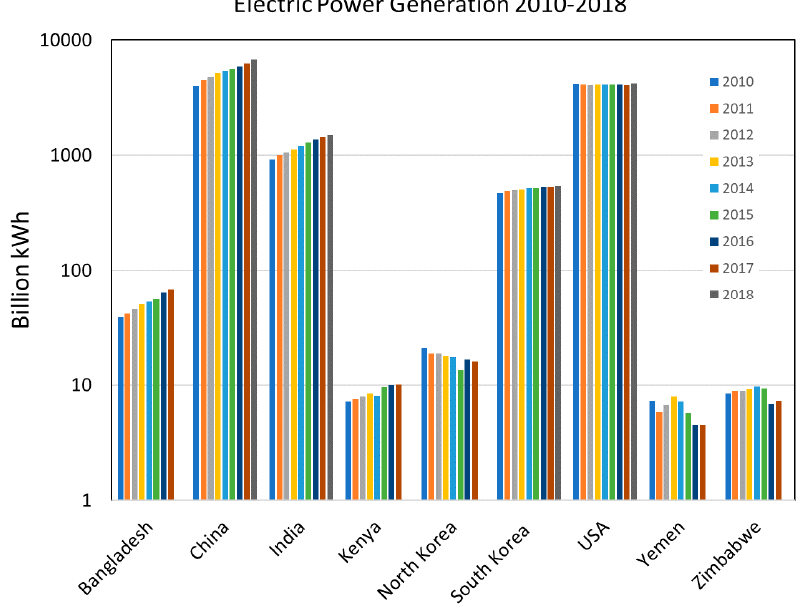
Figure 1. Electric power generation for the nine countries with test sites in this study from 2010 to 2018. Data from the International Energy Agency (IEA) [6].